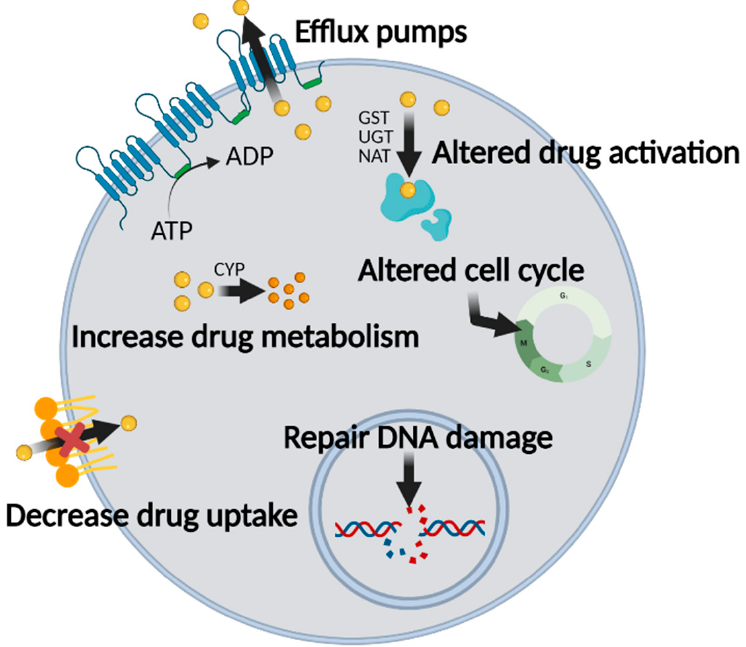
Figure 1. Brief overview of the various mechanisms of MDR that evolve in cancer cells. Image created with BioRender icons. Mechanisms of MDR include efflux via ATPase-dependent membrane pumps; altered drug activation; increased drug metabolism; decreased drug uptake through alterations in membrane lipids; altered cell cycle; and repair of DNA damage to inhibit apoptosis.